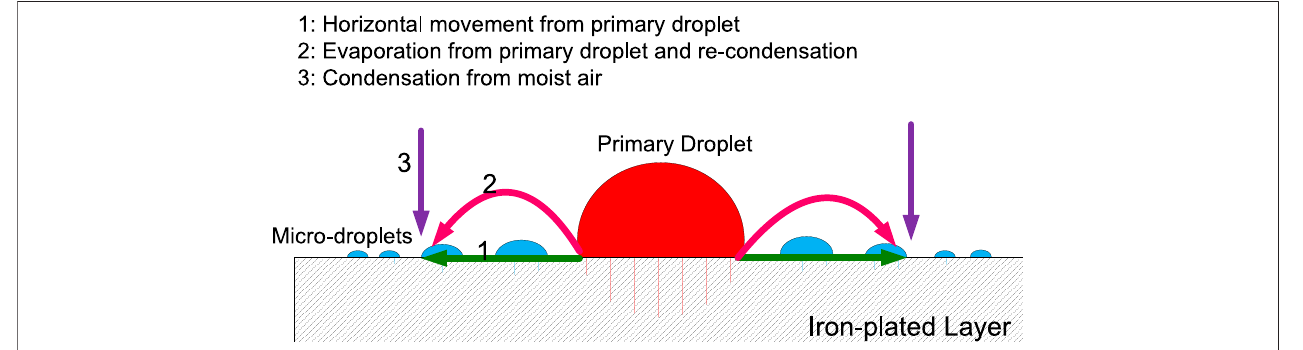
FIGURE 8 | Schematic representation of possible microdroplet formation